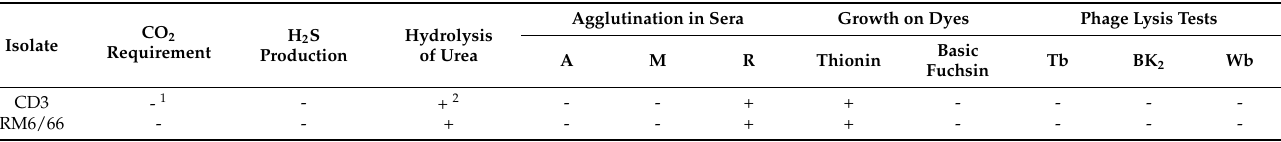
Table 2. Biotyping characteristics of B. canis RM6/66 and the isolate CD3 from the subclinically infected pet dog in Sichuan, China.